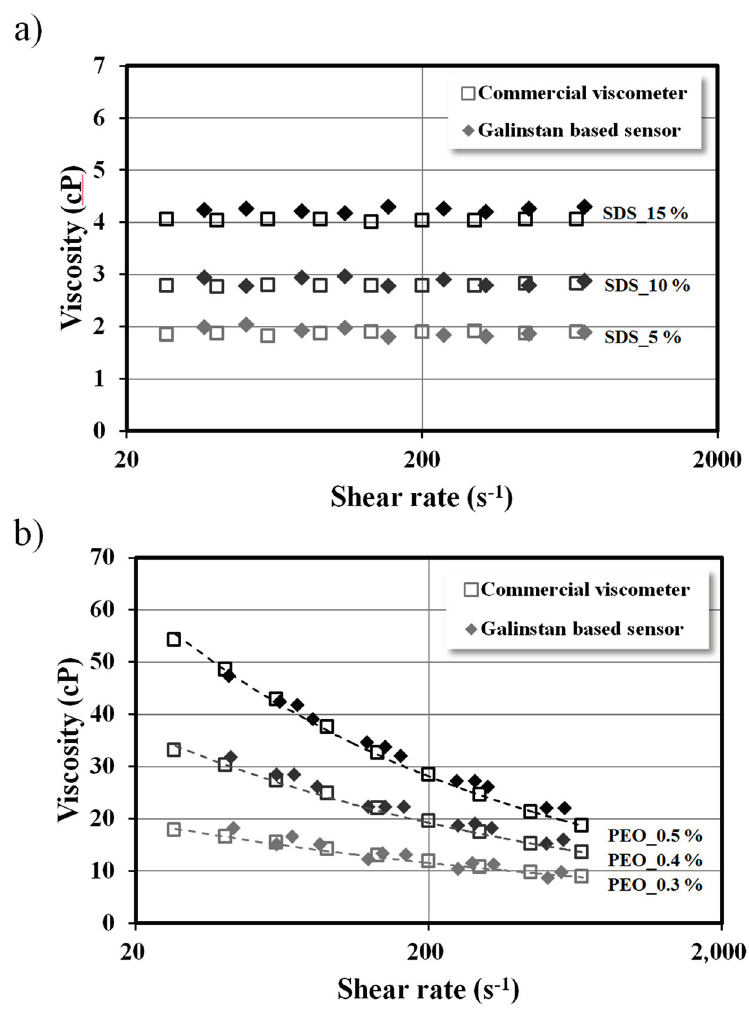
Figure 6. Viscosity measurement results of ( a ) 5%, 10%, and 15% SDS solution as a Newtonian fluid and ( b ) 0.3%, 0.4%, and 0.5% PEO solutions under a shear-rate